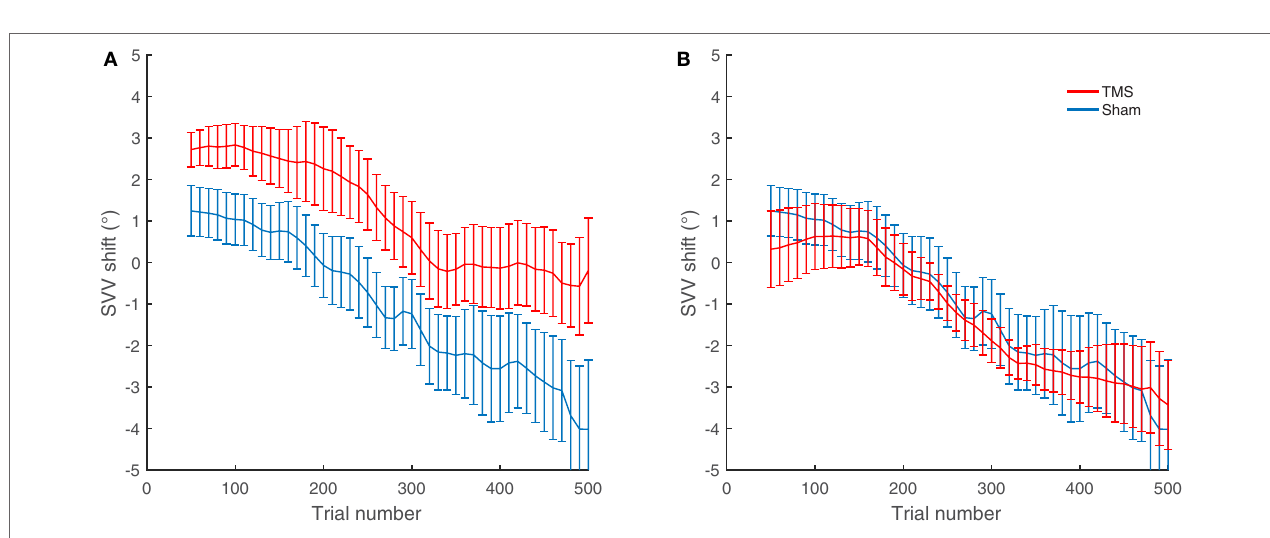
FigUre 5 | Average SVV shift following TMS and sham stimulation in nine participants who had TMS at different cortical locations. (a) The average SVV shift from TMS at SMGp is in the opposite direction of the head tilt and larger than the average SVV shift from the sham stimulation ( p = 0.01). (B) The average SVV shift from TMS at other cortical locations is not different from the average SVV shift from the sham stimulation ( p = 0.77). Error bars represent